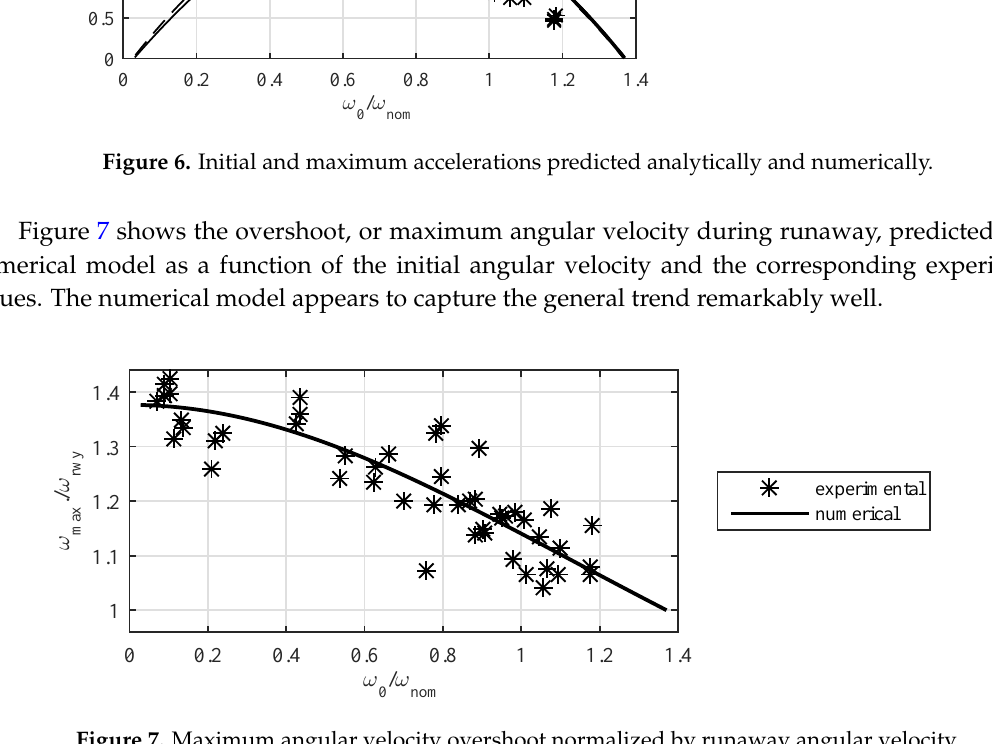
Figure 7. Maximum angular velocity overshoot normalized by runaway angular